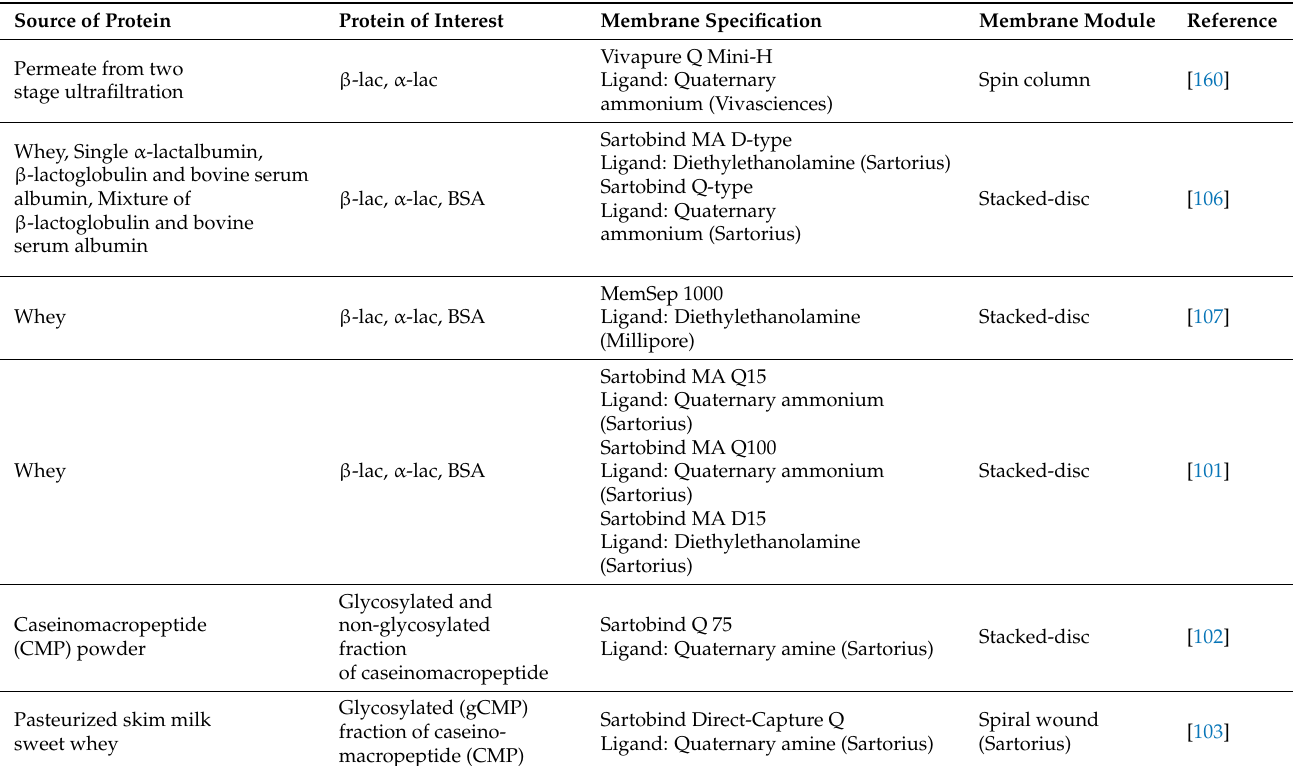
Table 3. Fractionation of proteins from whey by anion-exchange